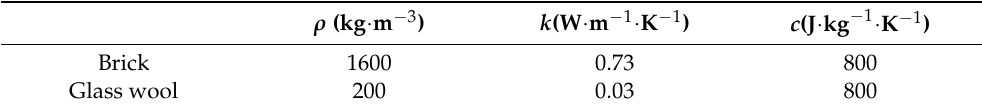
Table 1. The properties of the materials used.